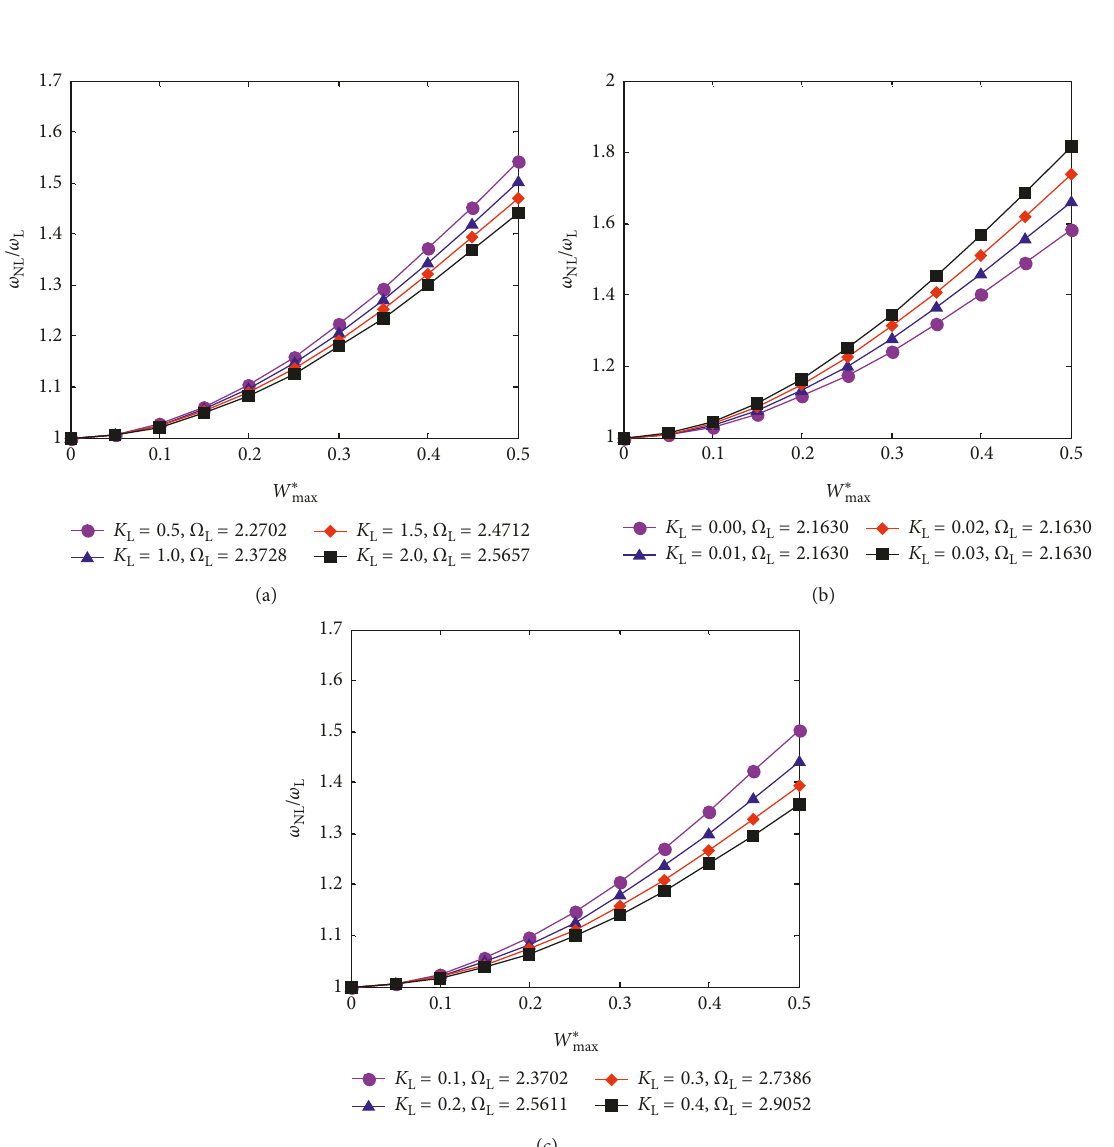
Figure 3: Nonlinear frequency ratios versus dimensionless vibration amplitude of H-H FG-CNTRC beams for different values of elastic foundation coefficients ( H 0 . 1m, L / H 25, V (cid:29) (cid:29)